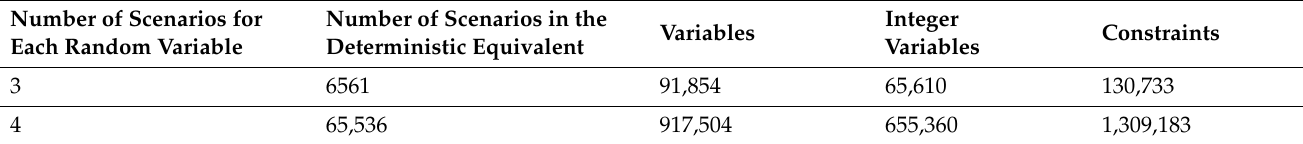
Table 2. Comparison of the size of the models